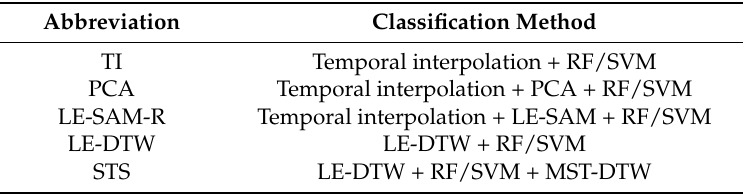
Table 1. Comparison of five classification methods.